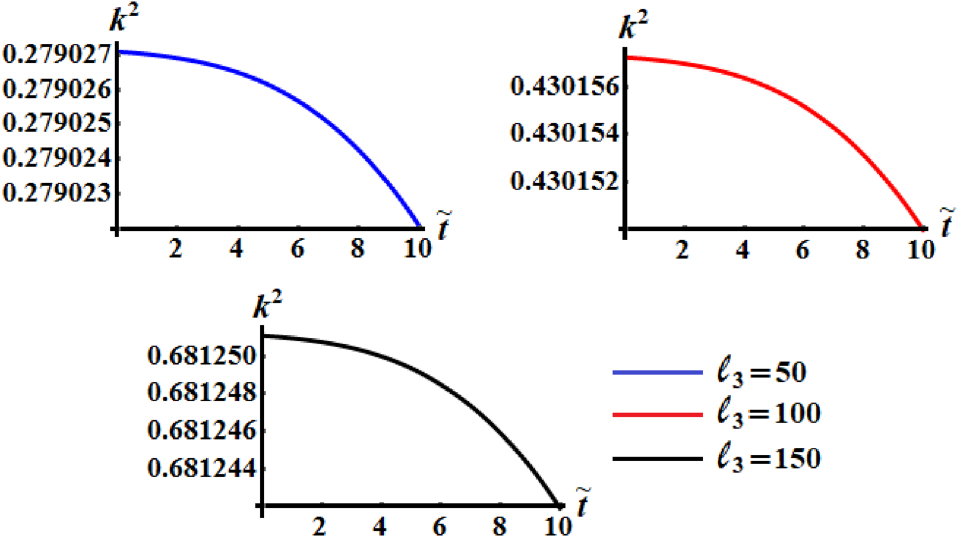
Figure 13. Describes the time history of k 2 when (ℓ 1 , ℓ 2 ) = ( 200, 150 ) kg m 2 s − 1 a ℓ 3 ( = 50, 100, 150 ) kg m 2 s − 1 .